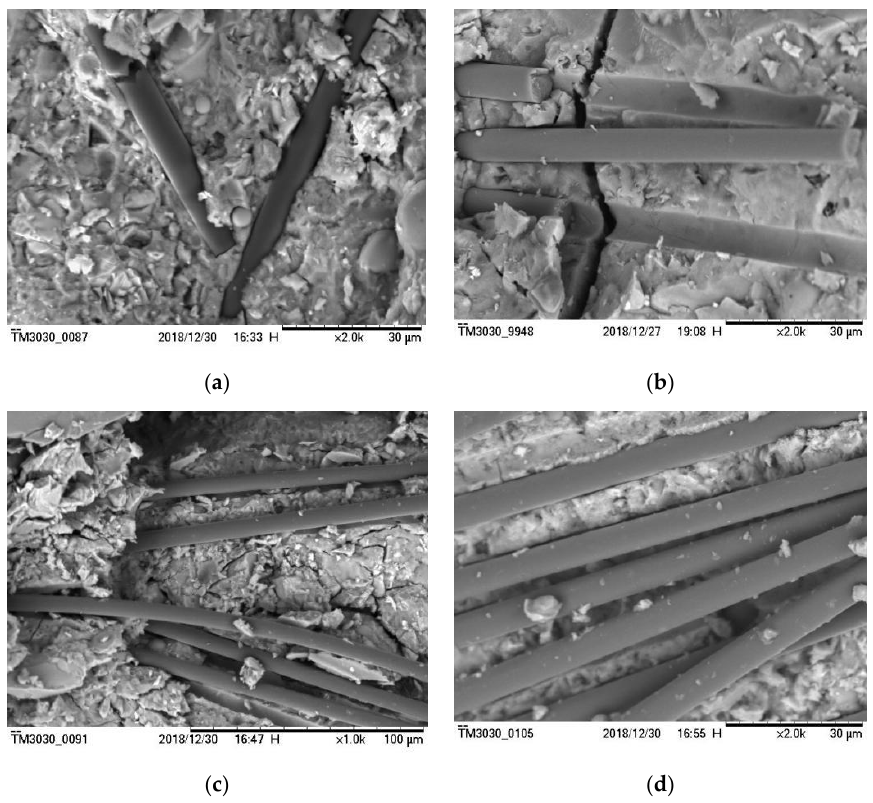
Figure 10. Picture of carbon fiber in cement base: ( a ) 0.5%, ( b ) 0.75%, ( c ) 1.0%, ( d ) 1.25%.